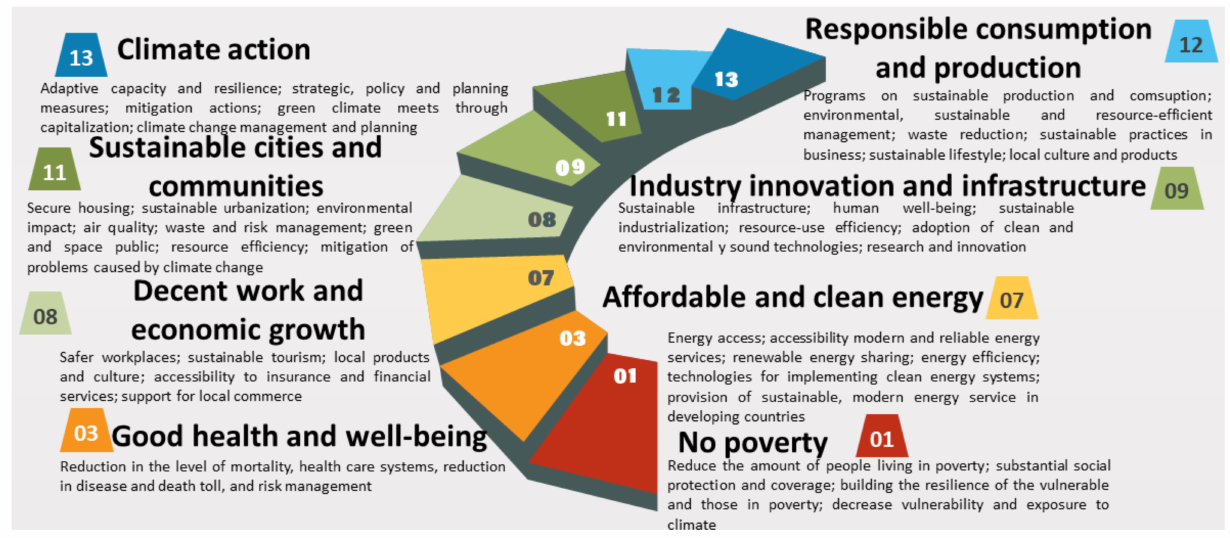
Figure 8. SDGs associated with thermal comfort. Adapted from Yang and Matzarakis [78] and WHO